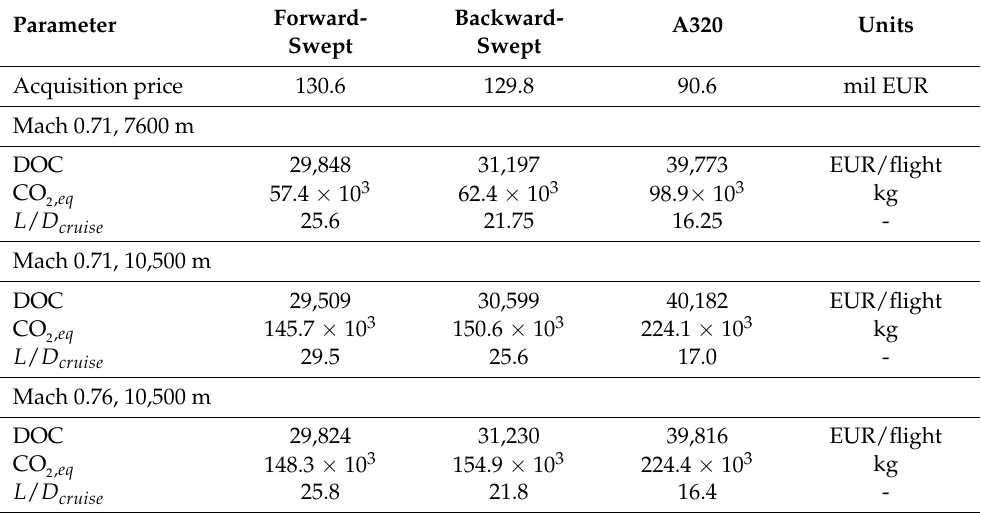
Table 8. Design-point summary and an off-design comparison of sized aircraft to A320. Parameter